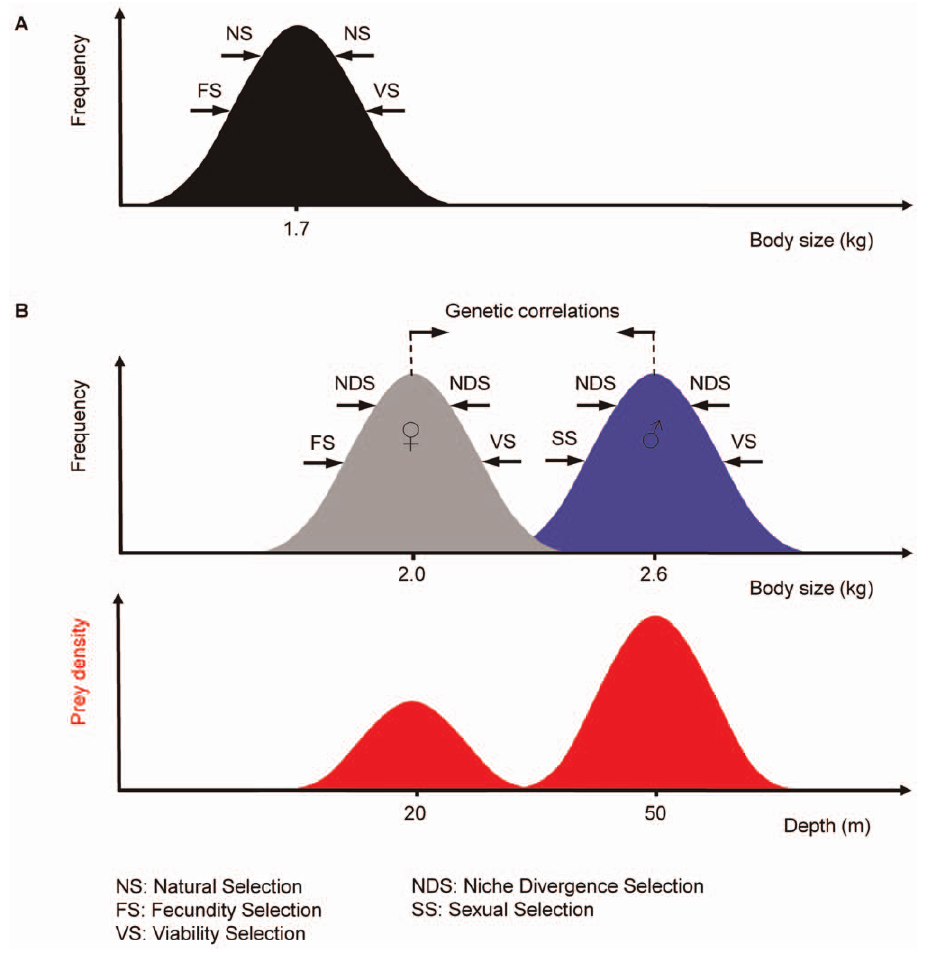
Figure 8. Selective forces influencing the evolution of body size in Blue-eyed Shags. (A) Theoretical situation with uniform prey density distribution with depth and absence of sexual selection. Under the influence of natural selection, body size is monomorphic and stabilizes around 1.7 kg (value derived from regressions in Figure 6B and 6D). Birds have the optimal size for carrying out dives with the highest efficiency (shallow dives 5–10 m deep: ‘optimal breathing’). A bigger body is also maximally efficient at such depths, but is counter-selected by viability selection. (B) Present situation with a heterogeneous prey density distribution with depth and sexual selection. Under the influence of sexual niche divergence selection, the body size of one or of both sexes stabilizes around a value that is optimal for exploiting a specific prey patch (actual examples of body size and depth measured for birds from the Pointe Suzanne colony at Kerguelen). Fecundity selection is indicated in both situations. However, because of the phylogenetic constraints for brood size and the high cost of rearing progeny in altricial birds, we considered fecundity selection to have a relatively limited influence on the present evolution of body size and SSD in Blue-eyed Shags. Drawn using concepts found in [84].